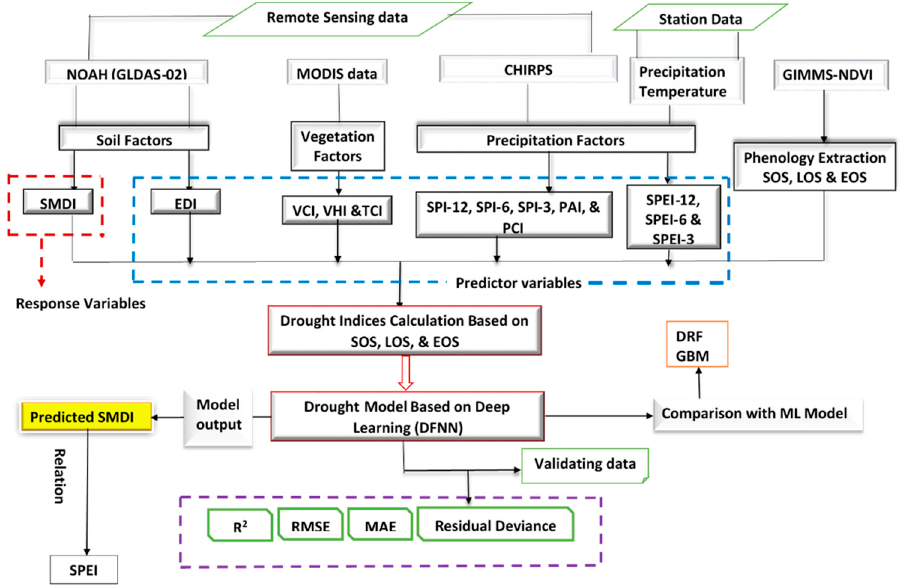
Figure 2. Methodological flowchart of the study. The dashed blue and red color boxes at the middle indicate the predictor and response variables, respectively. The purple dashed color box at the bottom represents the model validation metrics.